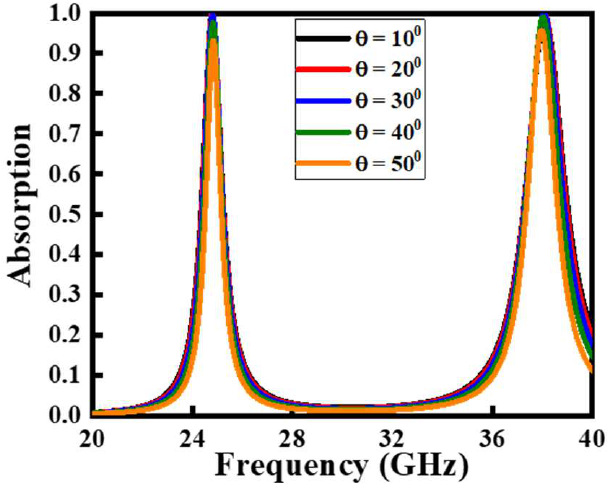
Figure 5. The absorption rate of the proposed MMA at different incidence angles of the EM waves. θ represents the incident angle of the incoming EM waves.